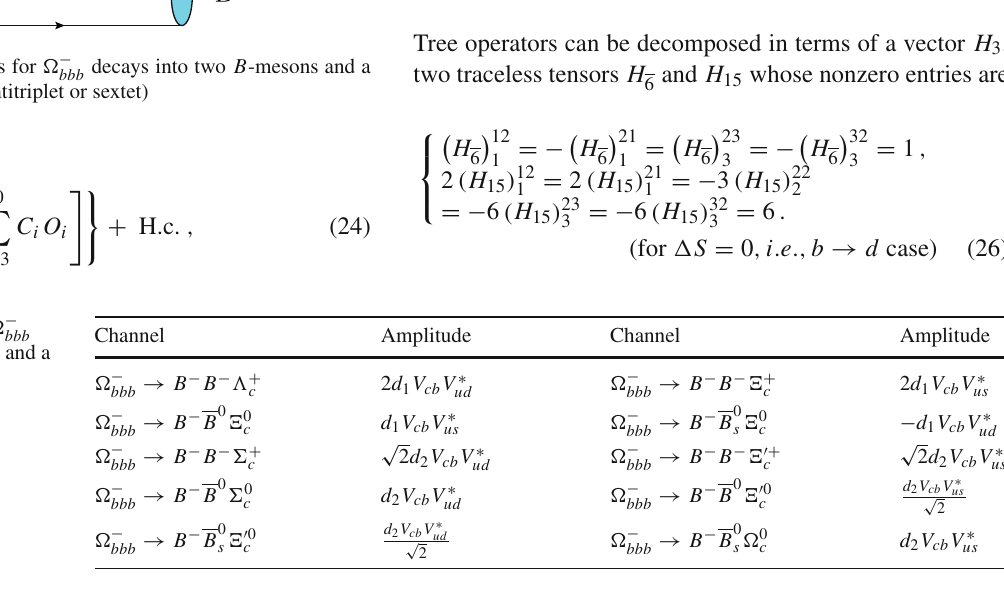
Table 6 Amplitudes for (cid:2) − decays into two B -mesons and a singly charmed baryon (antitriplet or sextet)